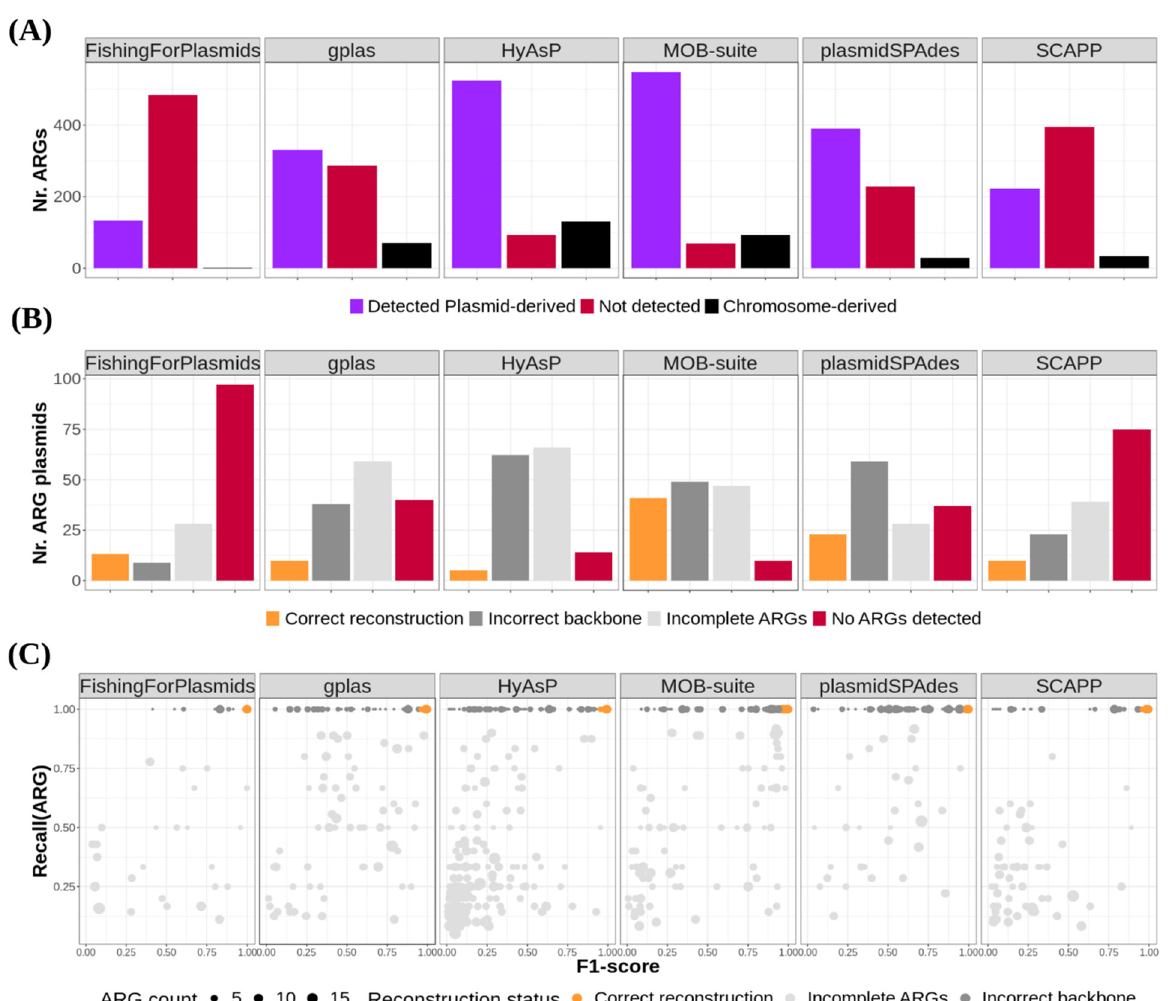
Figure 4. ( A ) Bar plot displaying the number of plasmid-derived ARGs that were detected/not detected by each of the tools. This plot also shows the number of chromosome derived ARGs included in the plasmid predictions. ( B ) Bar plot displaying the number of reference ARG-plasmids belonging to each different reconstruction category. Reconstruction categories were defined as follows. Correct reconstruction: all ARGs were predicted in the same bin (Recall(ARG) = 1) and the backbone of the plasmid was correct (F1-score ≥ 0.95). Incorrect backbone: all ARGs were predicted in the same bin (Recall(ARG) = 1) but the backbone of the plasmid was incorrect (F1-score < 0.95). Incomplete ARGs: Not all ARGs were included in the same bin (Recall(ARG) < 1). No ARGs detected: None of the ARGs derived from the reference plasmids were included in any bins created by the tool. ( C ) Scatter-plot showing relation between Recall(ARG) and F1-score (bp) values for predictions that carry at least one ARG of plasmid origin. Dots are colored according to the same criteria as in B.